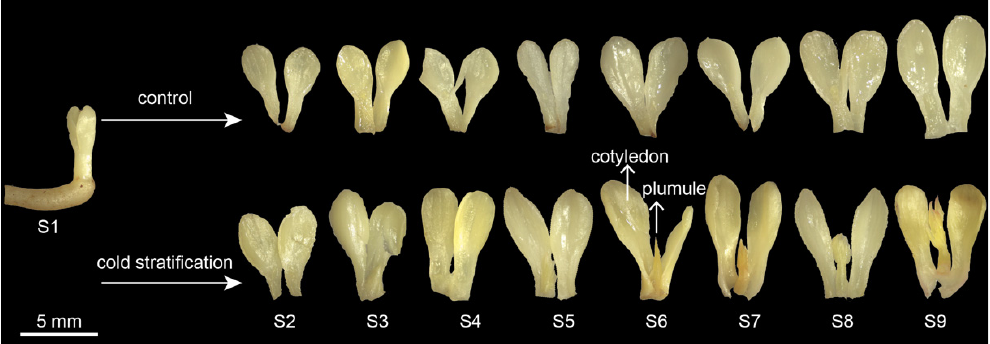
Figure 1. Morphological anatomy of P. emodi embryos during cold stratification. Note: Radicles have been removed before taking the photo.